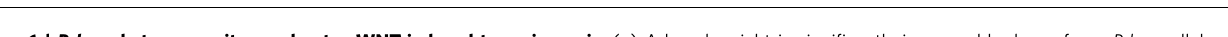
Figure 6 | Prkaca heterozygosity accelerates WNT-induced tumorigenesis. ( a ) Adrenal weight is significantly increased by loss of one Prkaca allele. Adrenal glands from wild-type, D Cat;Akr1b7:Cre and D Cat;Prkaca þ / (cid:2) ;Akr1b7:Cre mice were weighed on killing. ( b ) Prkaca heterozygosity accelerates WNT-induced hyperplasia and dysplasia. D Cat;Akr1b7:Cre (a) and D Cat;Prkaca þ / (cid:2) ;Akr1b7:Cre (b–d) adrenals were counterstained with haematoxylin and eosin. Pictures in b–d represent the range of phenotypes resulting from Prkaca heterozygosity. Scale bar, 400 m m. ( c , d ) Prkaca heterozygosity increases proliferation. Ki67 positive cells were counted in five high-power fields per adrenal (WT, n ¼ 3; D Cat;Akr1b7:Cre, n ¼ 4; D Cat;Prkaca þ / (cid:2) ;Akr1b7:Cre , n ¼ 9).Results are expressed as a labelling index. Pictures in d show high-power fields for one D Cat;Akr1b7:Cre adrenal (a) and three different D Cat;Prkaca þ / (cid:2) ;Akr1b7:Cre adrenals (b–d). ( e ) Prkaca heterozygosity is associated with increased malignancy. VegfA and Cnxa43 expression levels were analysed by RT–qPCR in wild-type ( n ¼ 5), D Cat;Akr1b7:Cre ( n ¼ 7) and D Cat;Prkaca þ / (cid:2) ;Akr1b7:Cre ( n ¼ 12) adrenals. ( f , g ) Prkaca heterozygosity increases WNT pathway activity. ( f ) Axin2 and Lef1 expression levels were analysed by RT–qPCR ( g ) LEF1 expression was analysed by immunohistochemistry in D Cat;Akr1b7:Cre and D Cat;Prkaca þ / (cid:2) ;Akr1b7:Cre adrenals. Insets show ectopic accumulation of LEF1 within ZF. Scale bar, 100 m m. ( h ) Low StAR expression is associated with lower overall survival in ACC patients. The patients were separated as two equivalent groups of high ( n ¼ 39) and low ( n ¼ 40 ) StAR expression. Left panel: Kaplan–Meier estimates of overall survival. Right panel: patients were ordered by cut-off-centred StAR expression. Dark grey boxes indicate specific death. ( i ) WNTpathway activity is inversely correlated with StAR expression in ACC patients. Adrenocortical carcinoma patients with no mutation in CTNNB1 , APC and ZNRF3 were selected and a WNTpathway activation signature was established based on expression levels of LEF1 , AXIN2 and APCDD1 . Left panel: Spearman correlation between WNTsignature and StAR expression. Right panel: hierarchical clustering of patients as a function of StAR expression and corresponding levels of WNTgene signature and individual WNT target genes expression. Bars in e , f represent mean expression ± s.e.m. Statistical analyses in a , c , e and f were conducted by one-way ANOVA followed by Tukey’s post hoc * P o 0.05; ** P o 0.005; *** P o 0.0005; NS, not